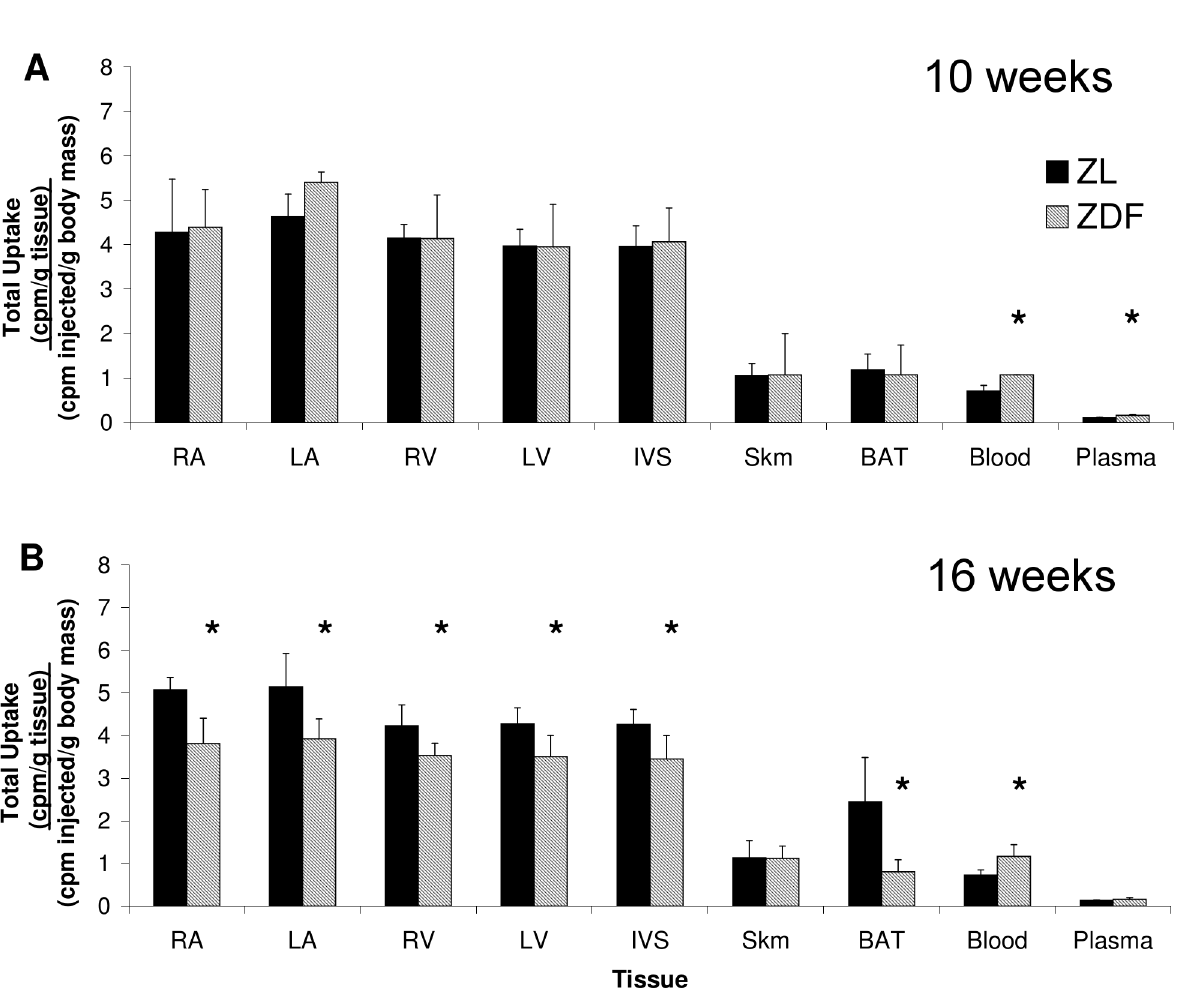
Fig 2. Total uptake of [ 3 H]CGP12177. Total uptake [ 3 H]CGP12177 in RA, LA, RV, LV, IVS, Skm, BAT, blood, and plasma of 10 (A) and 16 (B) week old ZDF and ZL. Total uptake expressed as [(cpm / g tissue) / (cpm injected / g body mass)]. RA: right atrium; LA: left atrium; RV: right ventricular free wall; LV: left ventricular free wall; IVS: intraventricular septum; Skm: quadriceps skeletal muscle; BAT: interscapular brown adipose tissue; cpm: counts per minute. Data are mean ± SD. n = 5 – 8 per group at each time point. * p < 0.05 vs ZL, Student ’ s